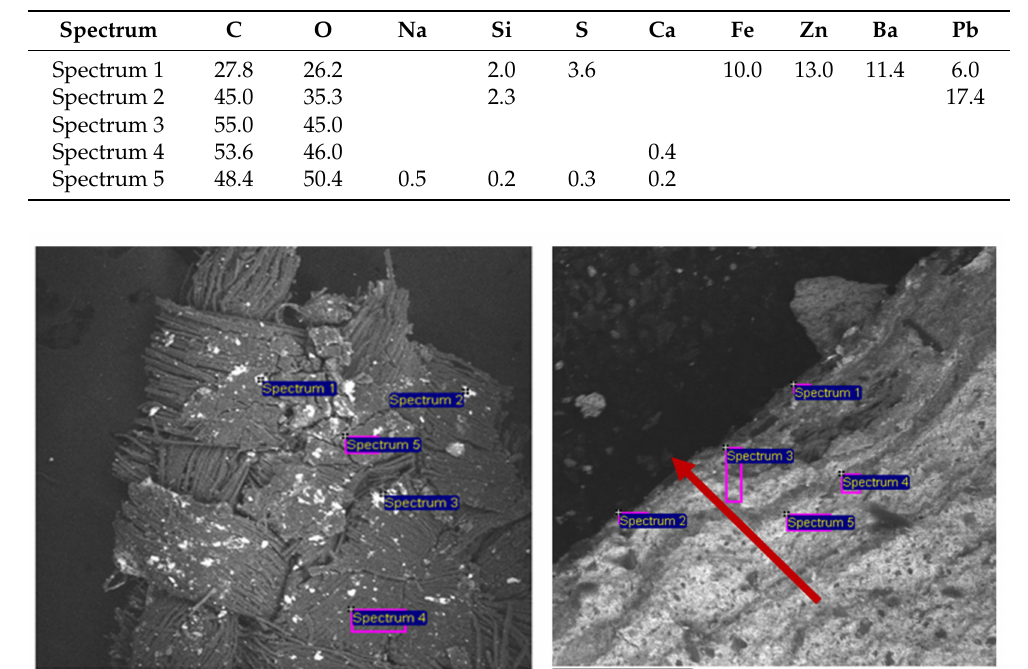
Table 1. Elements detected by EDS analysis of the areas shown in Figure 5a. Results are reported in weight percentage (w%).